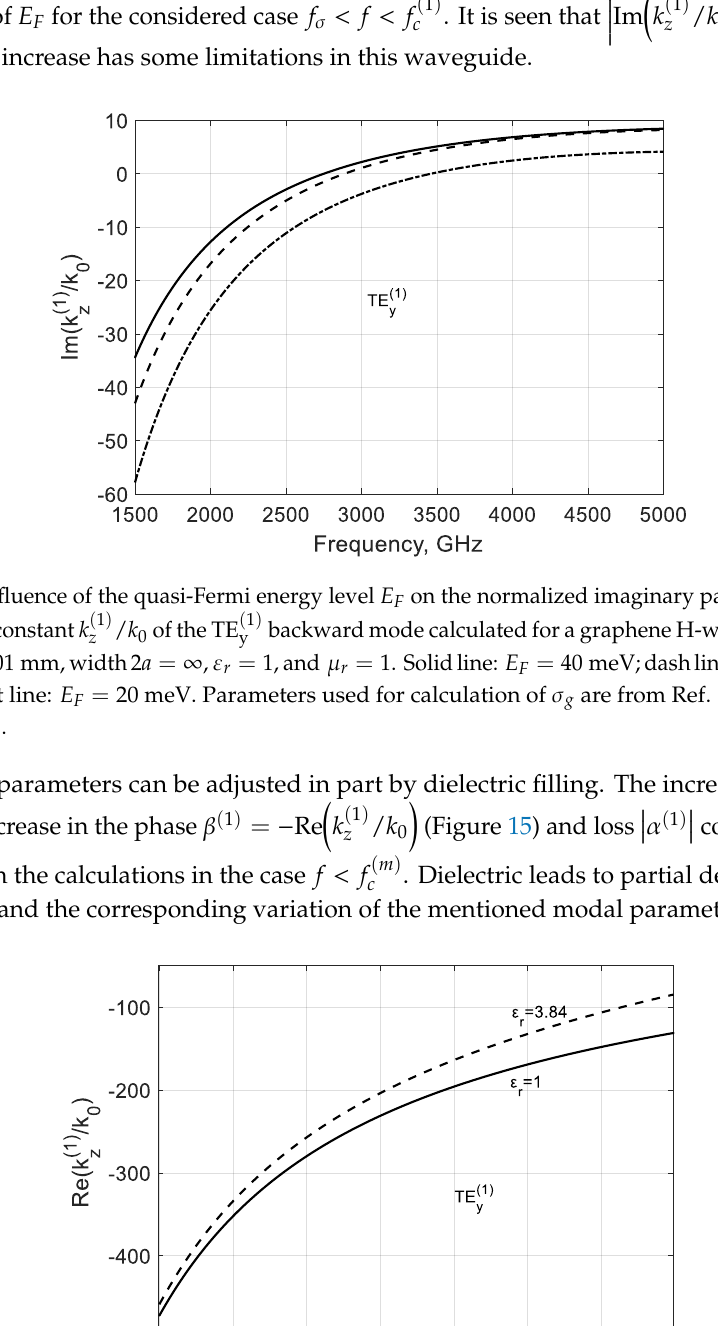
Figure 15. Influence of dielectric filling on the real part of propagation constant 1 0 z k k of the backward mode TE y calculated for a graphene H-waveguide of the height b ε µ r = 1.0; 3.84, and r = 1. Parameters used for calculation of E F = 40 meV, and τ = 1